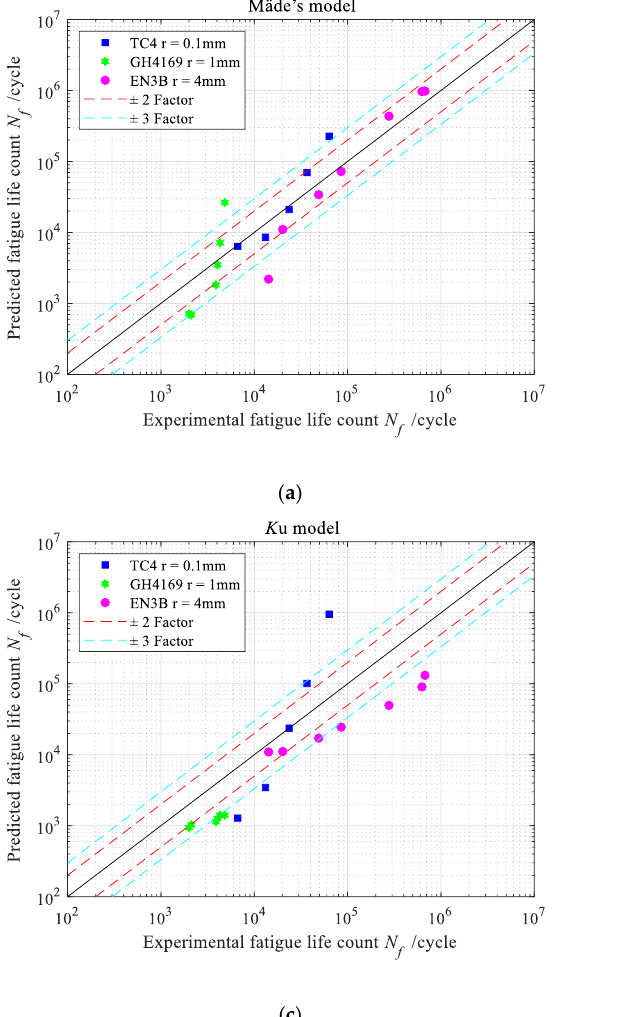
Figure 10. A comparison between tested lives and predicted lives using ( a ) Mäde’s model, ( b ) Wang’s model, ( c ) the K u model, and ( d ) the proposed model.